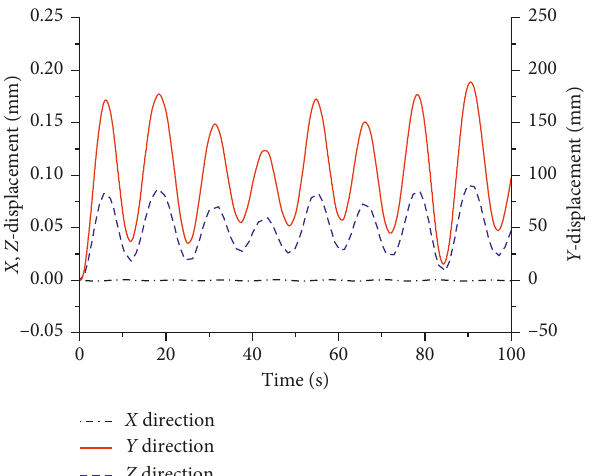
Figure 13: Amplitude of vibration acceleration vs. the working height of the inspection vehicle.